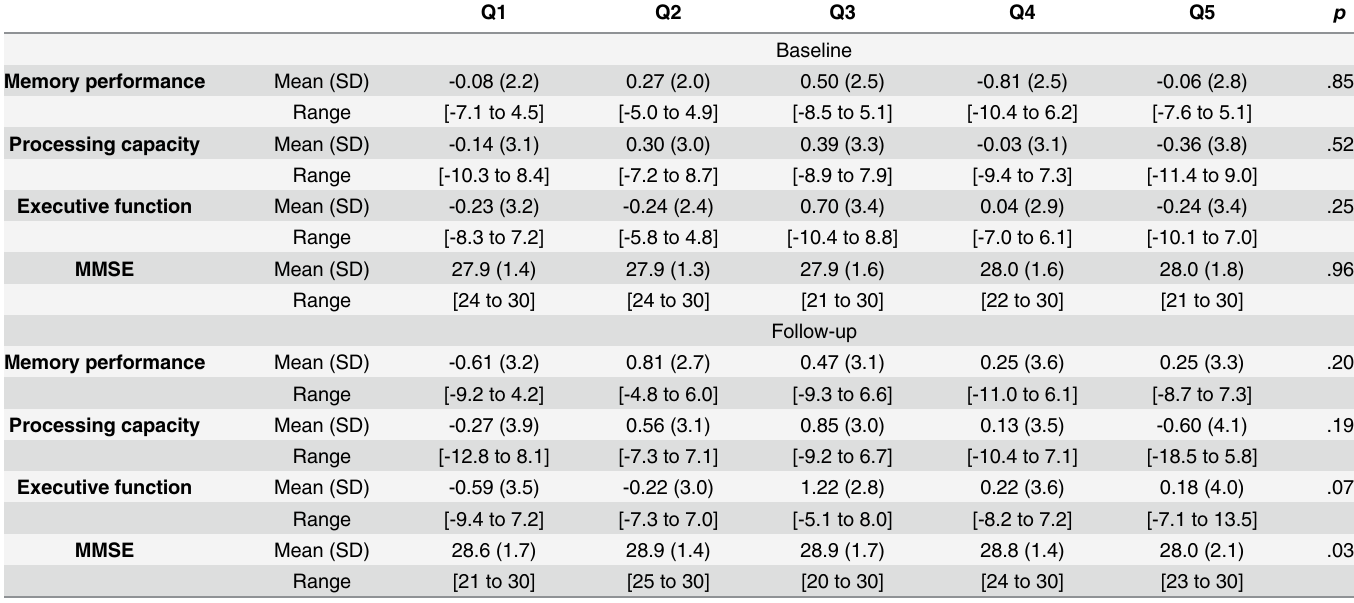
Table 2. Cognitive scores at baseline and